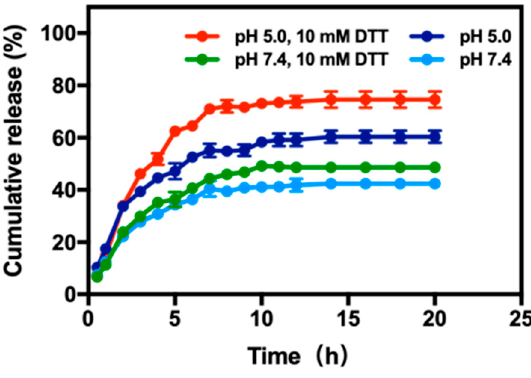
Figure 4. In vitro DOX release profiles from DOX/BSA NPs under different conditions at 37 °C.